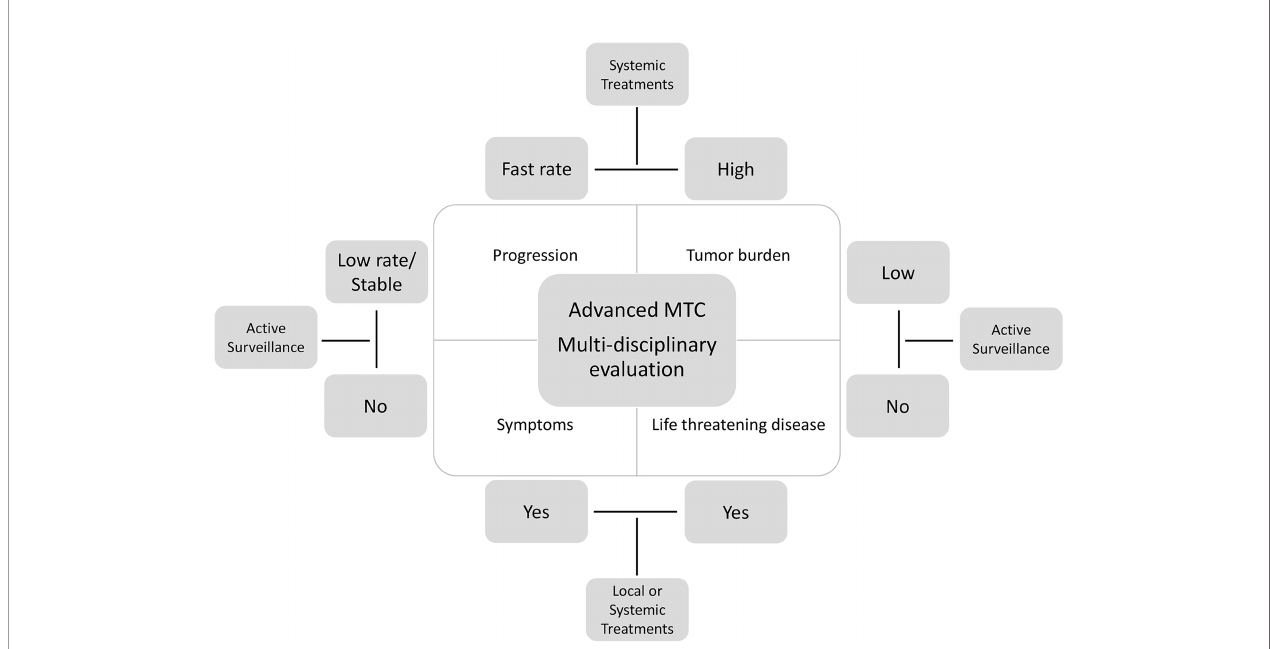
FIGURE 1 | Algorithm for the management of advanced MTC: not all cases require a systemic therapy. Active surveillance or local treatments can be appropriate in some cases according to the rate of growth, tumor burden, symptoms, and life-threatening